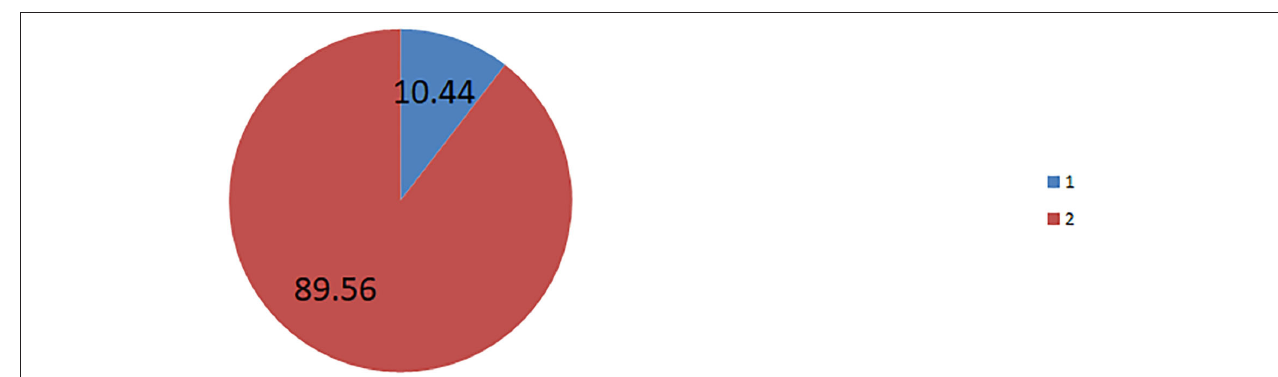
FIGURE 2 | The prevalence of husband/partner decision making power on contraceptive non-use, in Ethiopia.